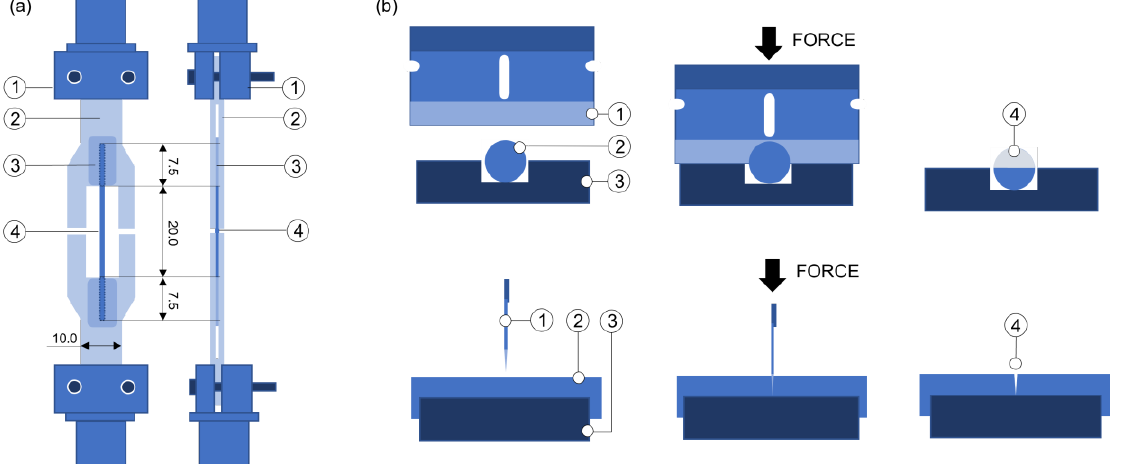
Figure 2. ( a ): Tensile test scheme: (1) mechanical clamp, (2) cardboard, (3) cyanoacrylate-based adhesive as a chemical clamp, (4) PLA or PLA-Mg filament. Units in millimetres; ( b ) notch-making procedure: (1) blade, (2) PLA or PLA-Mg filament, (3) carved steel plate, (4) produced notch.